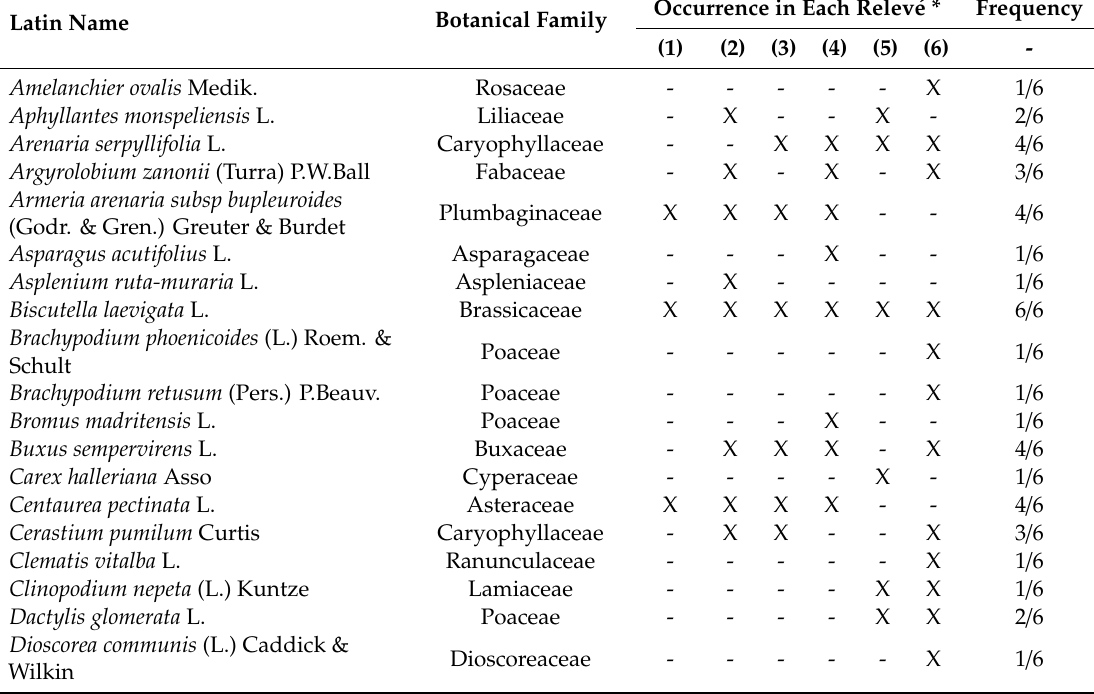
Table 2. Floristic list established during springtime and occurrence of each plant species in the 6 relev é s out of the 4 selected micro-habitats encountered at the former mine site. * (1): Metalliferous grassland; (2) and (3): Herbaceous formation on rocky raised areas; (4) and (5): Matorral with majorly shrubs; (6): Tree stands and frequency out of the 6 relev é